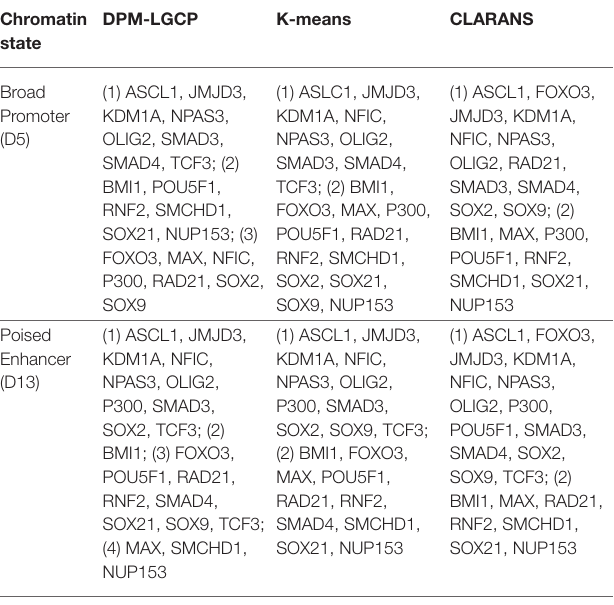
TABLE 1 | Comparison of clustering results with other methods.